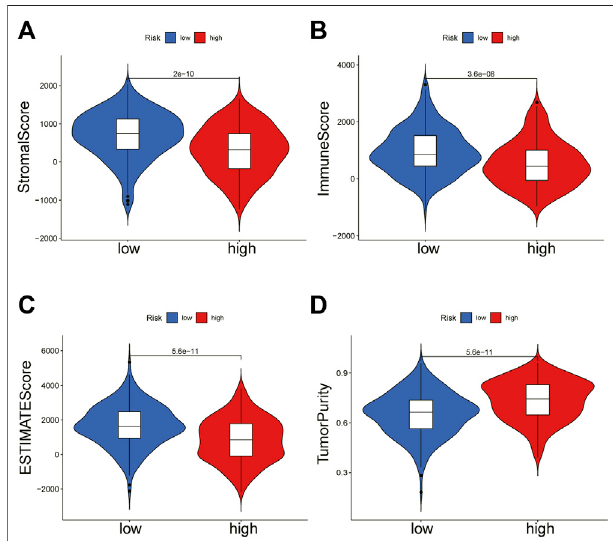
FIGURE 8 | ESTIMATE algorithm calculates immune score. The violin chart showed the comparison of stromal scores (A) , immune scores (B) , ESTIMATE scores (C) , and tumor purity (D) between the high-risk group and the low-risk group (Wilcoxon test, p <